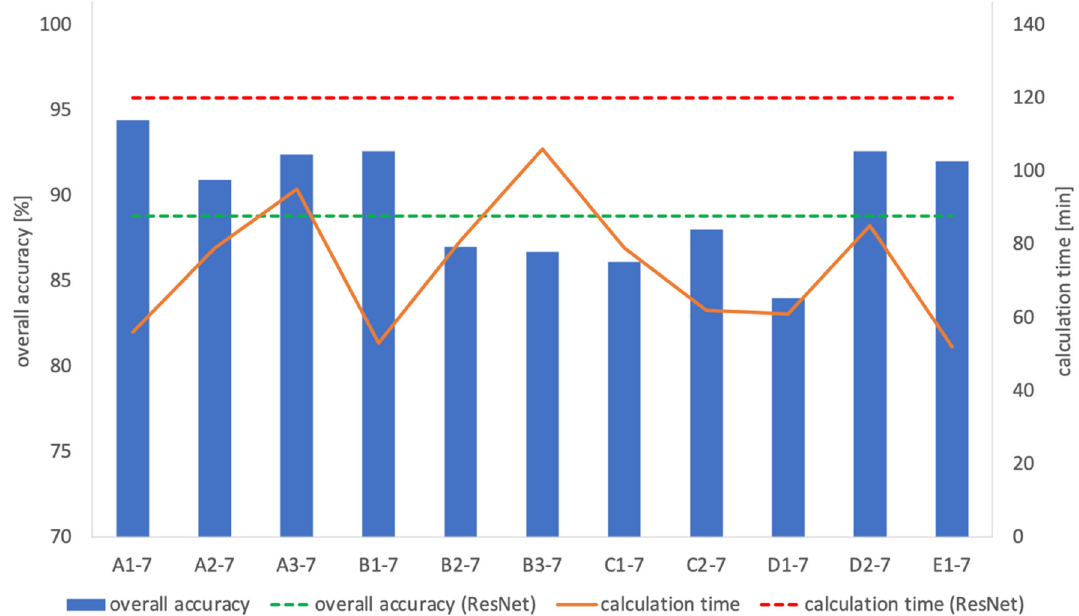
Figure 7. Overall accuracies and calculation times of the models with combination (the filter size of max-pooling: (7, 7)).